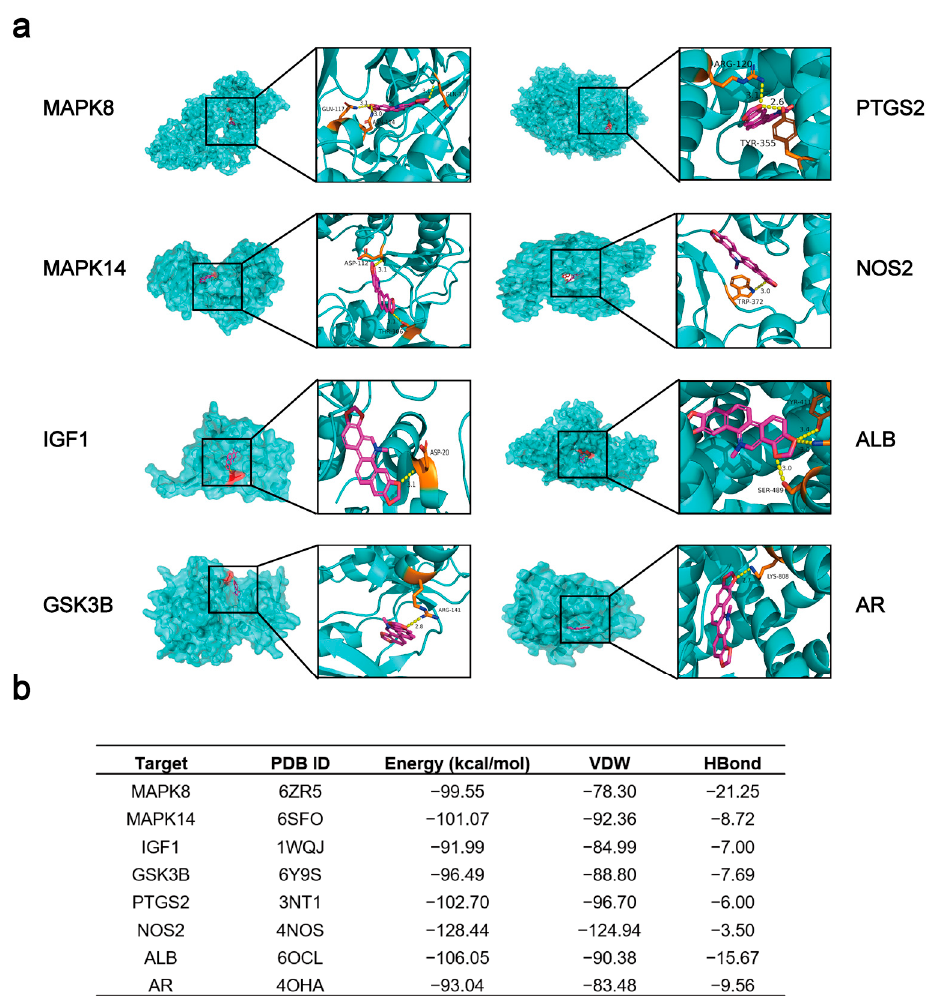
Table 2. The potential anti-PRRSV targets of sanguinarine. Names of Target Genes